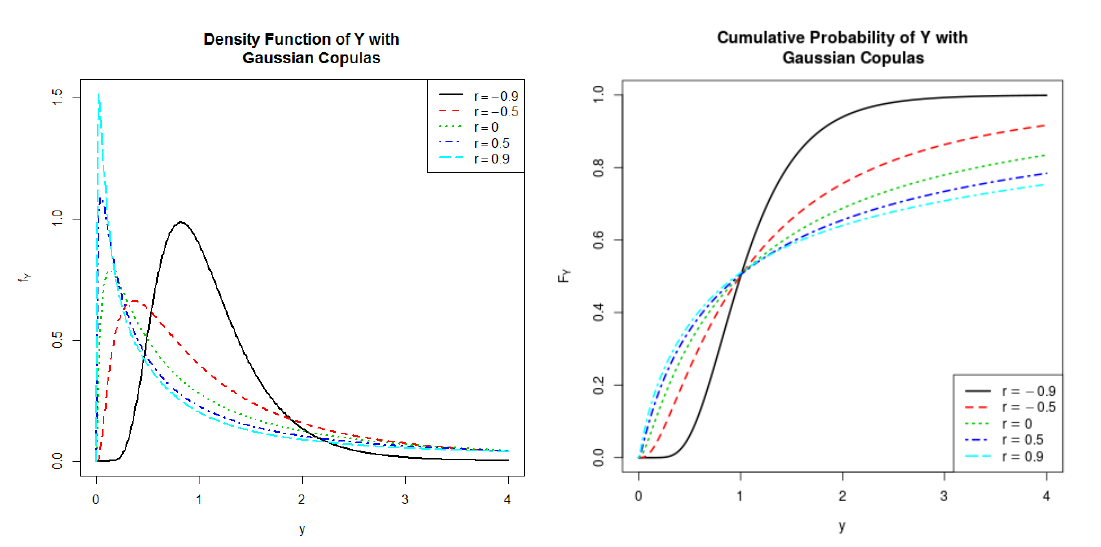
Figure 1. PDFs and CDFs of the product of two log-normal distributed random variables having Gaussian